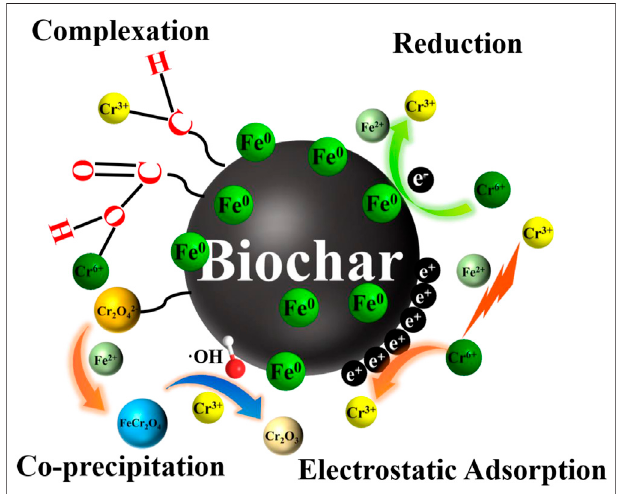
FIGURE 7 | Illustration of the theoretical Cr(VI) removal mechanisms of nZVI@CMBC, including reduction, electrostatic attraction, surface complexation, and co-precipitation.